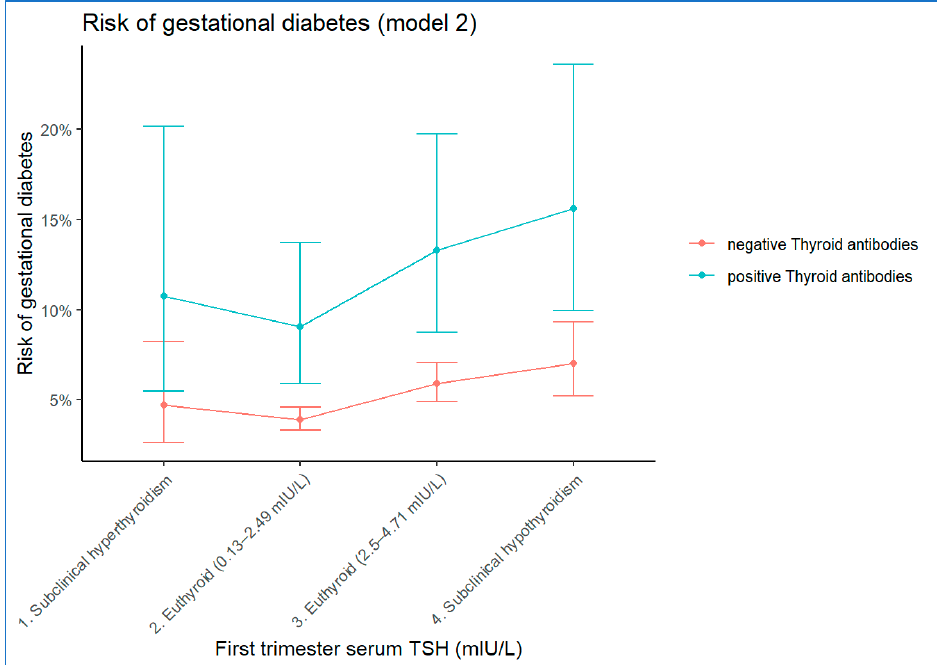
Figure 3. Risk of gestational diabetes mellitus predicted by model 2 for a representative 31-year-old patient, with no family history of type 1 diabetes mellitus, BMI between 18.5 and 24.99 kg/m 2 and without chronic hypertension.